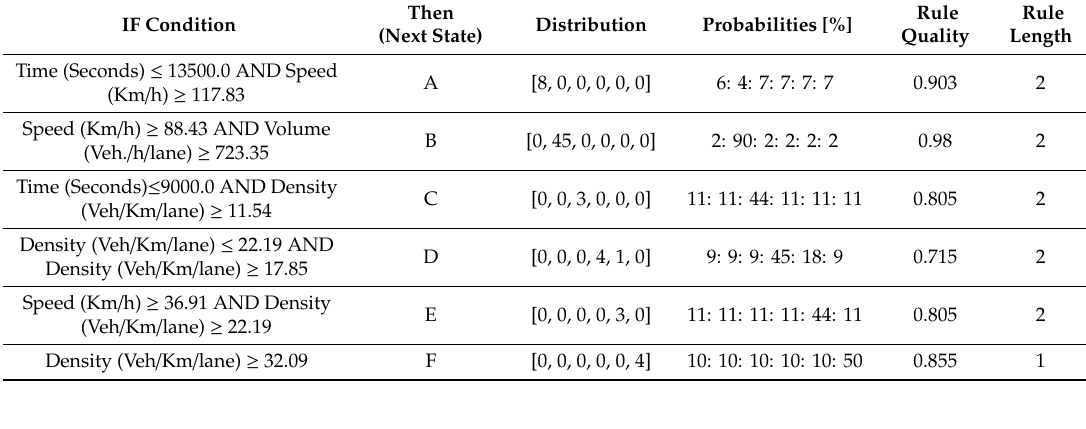
Table 1. Selected rules (for 15-min prediction horizon) with rule quality.